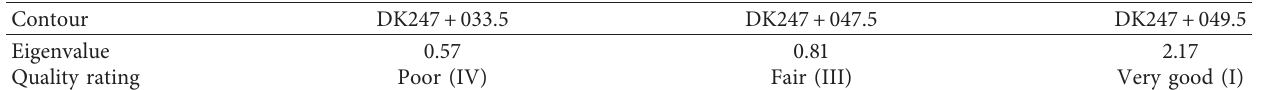
Table 19: Rating of total quality of measured tunnel